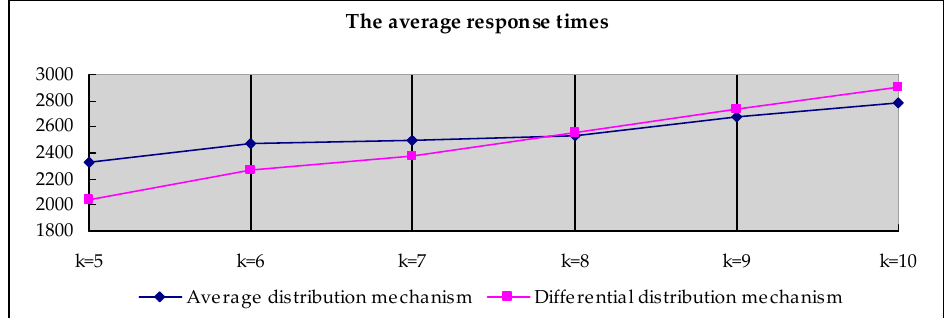
Figure 7. E ffi ciency comparison of two reward distribution Figure 7. Efficiency comparison of two reward distribution mechanisms.